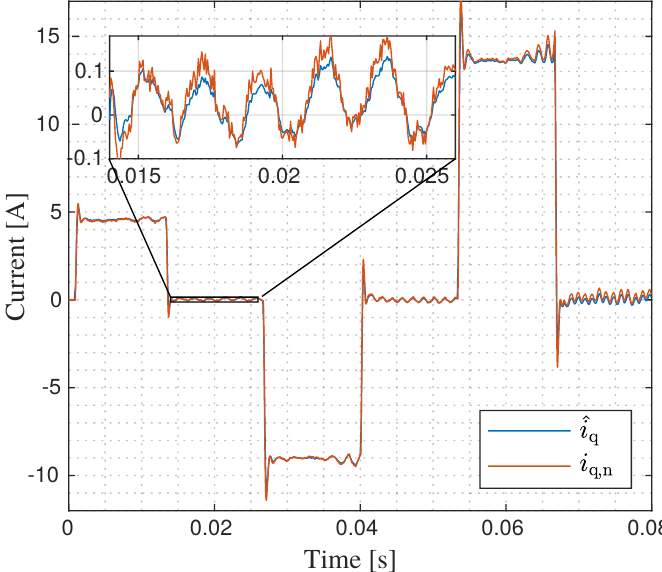
Figure 13. Measured and estimated results from the conducted experiment using torque mode with multiple step in torque reference with zero load—including the novel angle and speed and the Kalman/Luenberger observer. The zoomed areas depict the noise reduction capabilities of the Kalman/Luenberger